Question: What caption would you write for this figure?
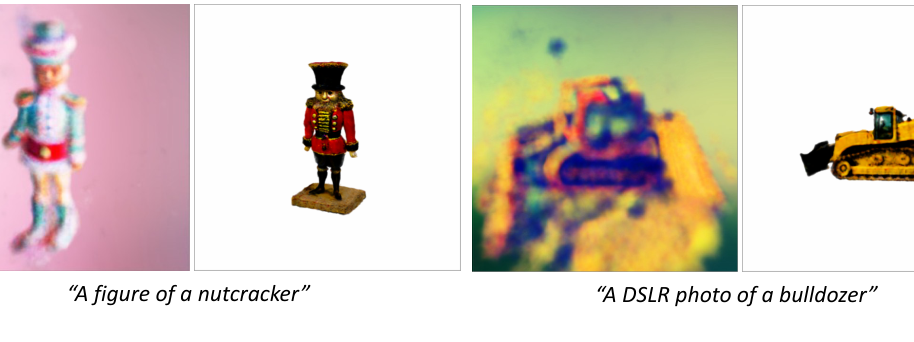
Answer: Intermediate renderings at 10,000th iteration.